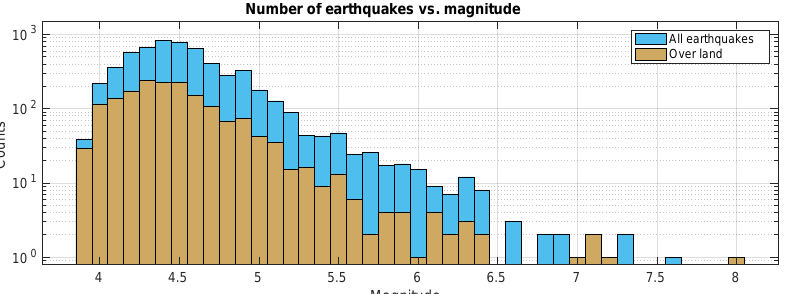
Figure 5. Histogram of earthquakes per magnitude during the period studied for all places (blue) and the ones happening on land (brown).